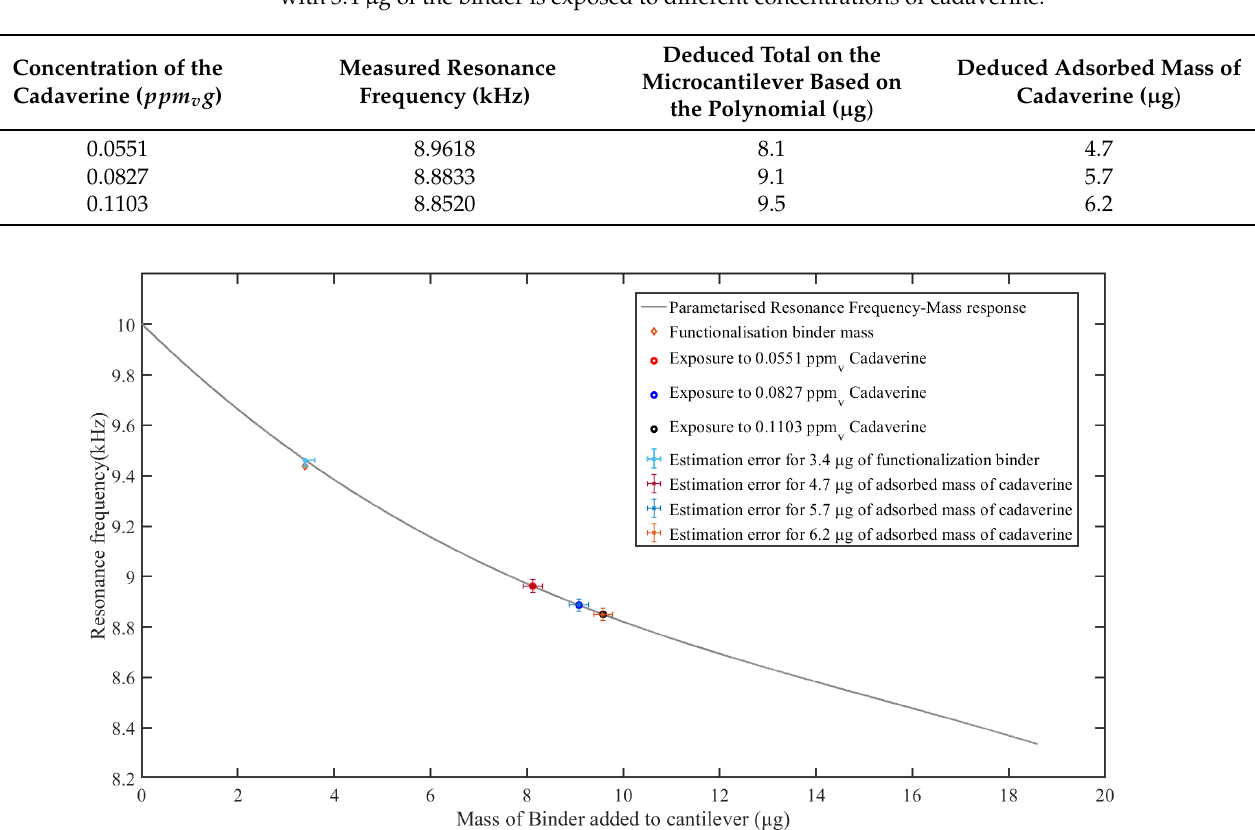
Figure 11. Estimation of the adsorbed mass on the microcantilever, using the polynomial from calibration set-2, after exposure to different concentrations of